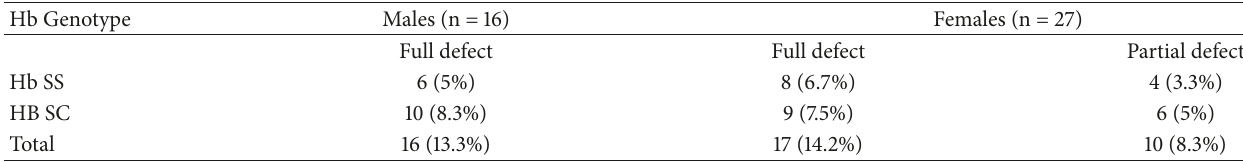
Table 2: G-6-PD defects among the different genotypes.